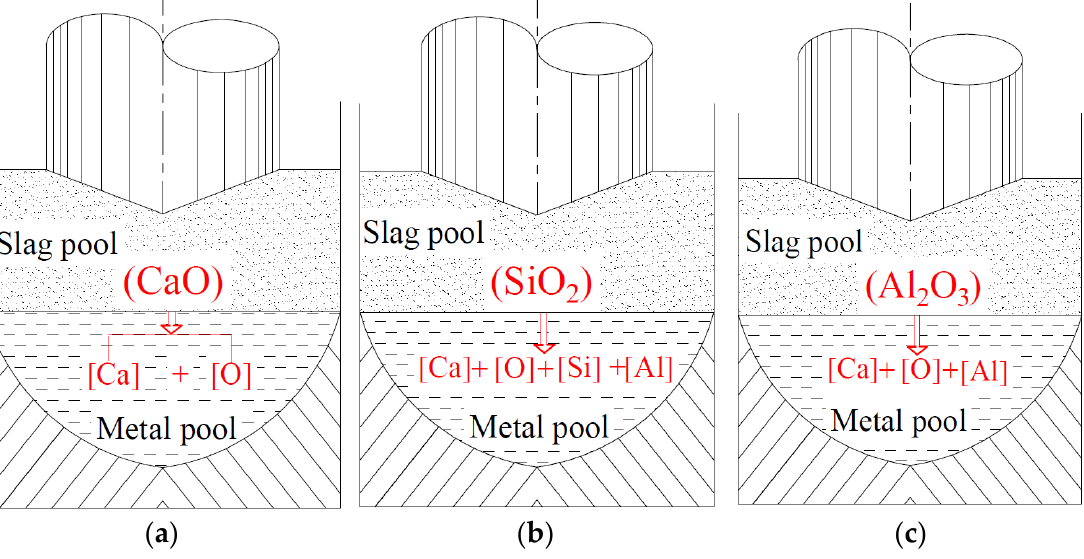
Figure 14. Reaction model between remelting slag system and molten steel. ( a ) High-basicity remelting slag. ( b ) Low-basicity remelting slag. ( c ) Al 2 O 3 -containing remelting slag. With the decrease in basicity, the content of free SiO 2 in the slag pool increased. Given the poor stability of SiO 2 at high temperatures, it decomposed more [O] in the metal bath. Given the stronger binding force of Ca, Al and O, the [Ca], [Al] and [O] in the metal bath formed calcium aluminate inclusions in the solidification process, as shown in Figure 14b.